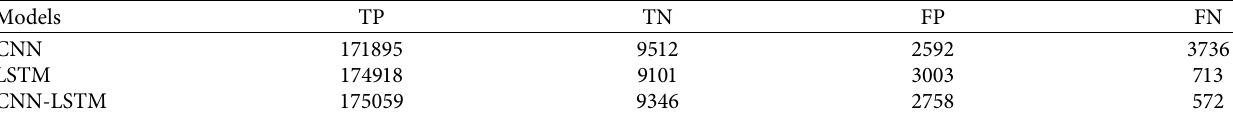
Table 7: Confusion matrices for the proposed framework in testing